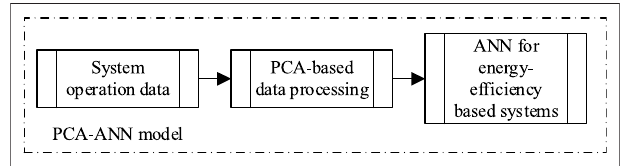
FIGURE 1 | The data processing process of PCA-ANN model.